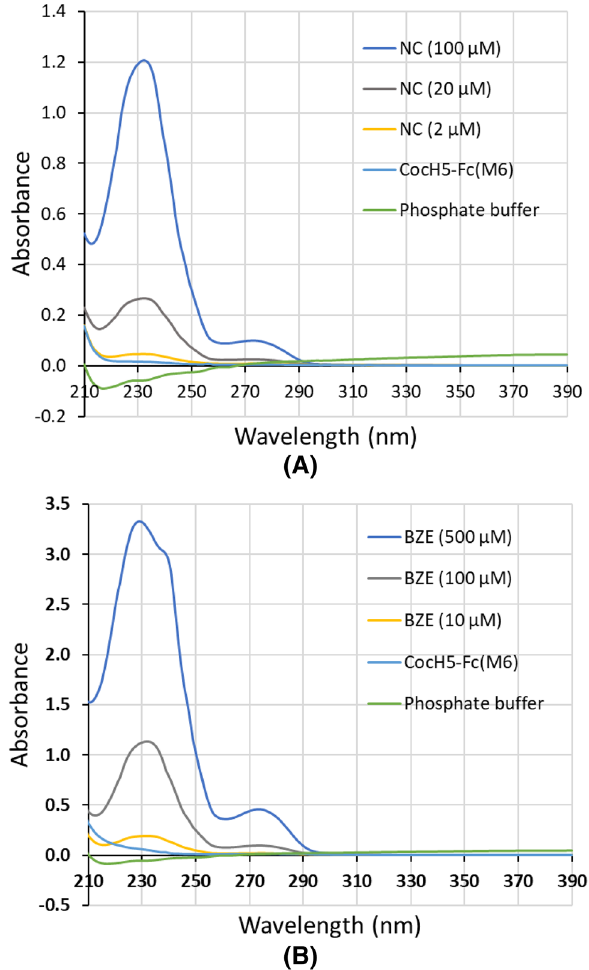
Figure 3. UV–visible absorption spectra of potassium phosphate buffer (blank), CocH5-Fc(M6) and substrates in buffer. ( A ) Norcocaine (NC). ( B ) Benzoylecgonine (BZE).